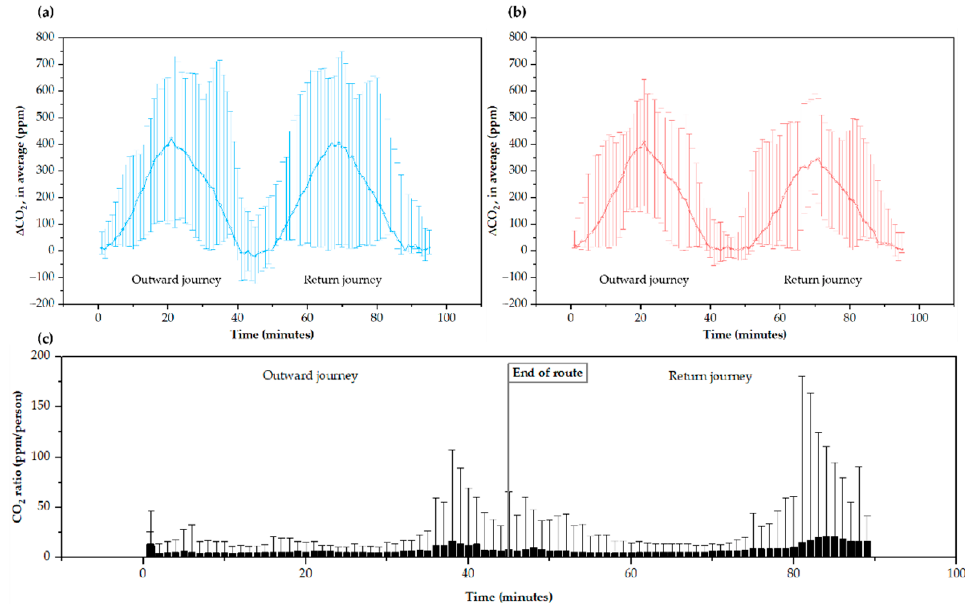
Figure 4. CO 2 increment average levels ( a ) in all weekday and ( b ) in all weekend routes, and ( c ) ppm/person ratio average and maximum gap along routes. The error bars in ( a , b ) correspond to the difference between the maximum/minimum data and the average data of all studied routes.